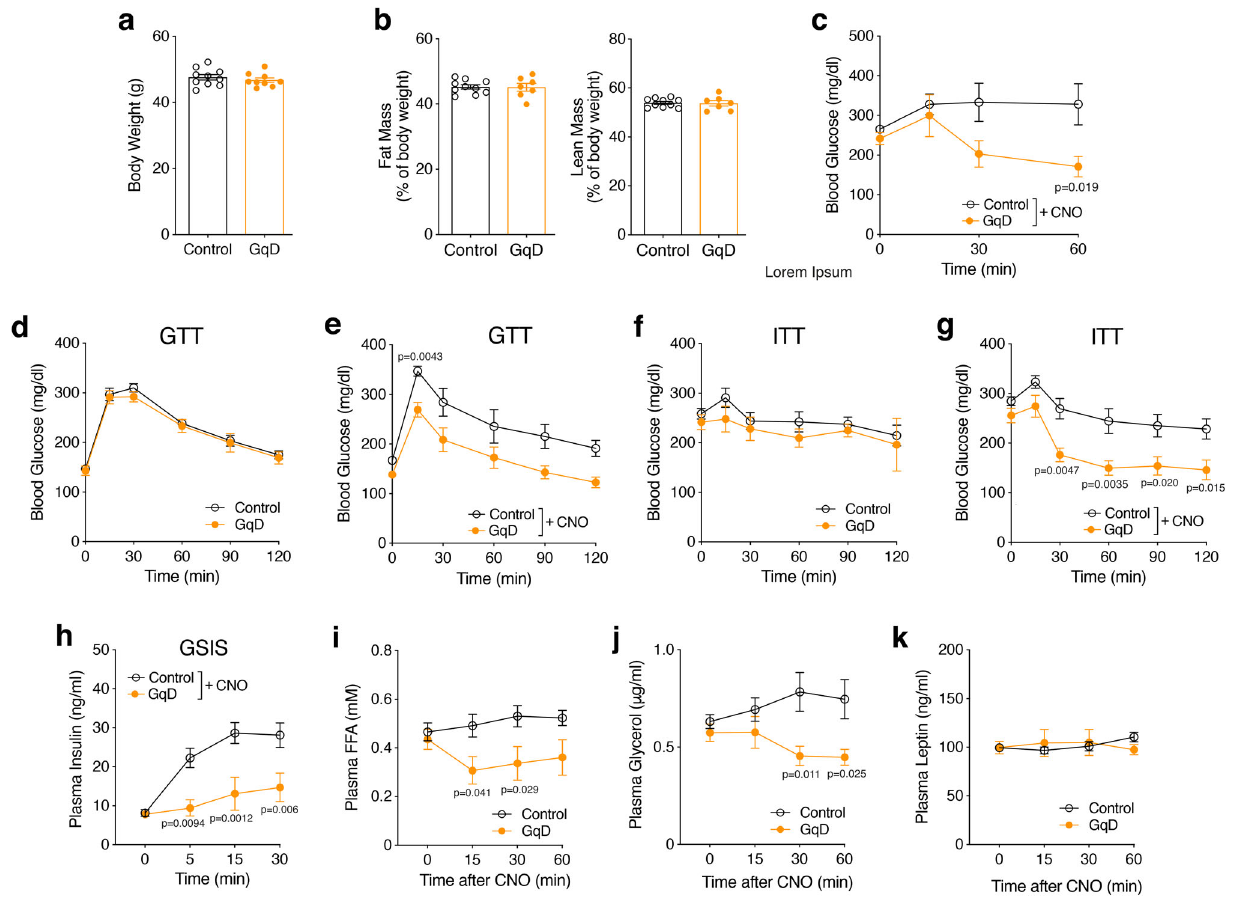
Fig. 2 Acute CNO treatment of adipo-GqD mice maintained on an obesogenic diet improves glucose homeostasis and suppresses lipolysis. a, b Body weight ( a ) and body composition (fat and lean mass as % of body weight) ( b ) of adipo-GqD and control mice maintained on high-fat diet (HFD) for 10 weeks prior to CNO treatment ( n = 7 – 10 per group). LSL-hM3Dq mice that did not harbor the adipoq-Cre transgene served as control animals throughout all experiments. c Blood glucose levels of HFD adipo-GqD and control mice after acute treatment with CNO (10 mg/kg i.p.) following a 4 hr fast. d , e Glucose tolerance test (GTT) without ( d ) and with ( e ) CNO treatment (10 mg/kg i.p.) after an overnight fast (16 hr). f , g Insulin tolerance test (ITT) without ( f ) and with ( g ) CNO treatment (10 mg/kg i.p.) after a 4 h fast. h Glucose-stimulated insulin secretion (GSIS). Plasma insulin levels of HFD adipo- GqD and control mice after i. p. treatment with glucose (2 g/kg) plus CNO (10 mg/kg) after a 4 h fast. i – k Plasma FFA ( i ), glycerol ( j ) and leptin ( k ) levels of HFD control and adipo-GqD mice after acute treatment with CNO (10 mg/kg i.p.) following a 4 h fast. In ( c – k ) mice were maintained on HFD for 10 – 14 weeks ( n = 5 – 10 per group). Data are shown as means ± s.e.m. c – k : two-way ANOVA followed by Bonferroni ’ s post hoc test). Source data are provided as a Source data fi